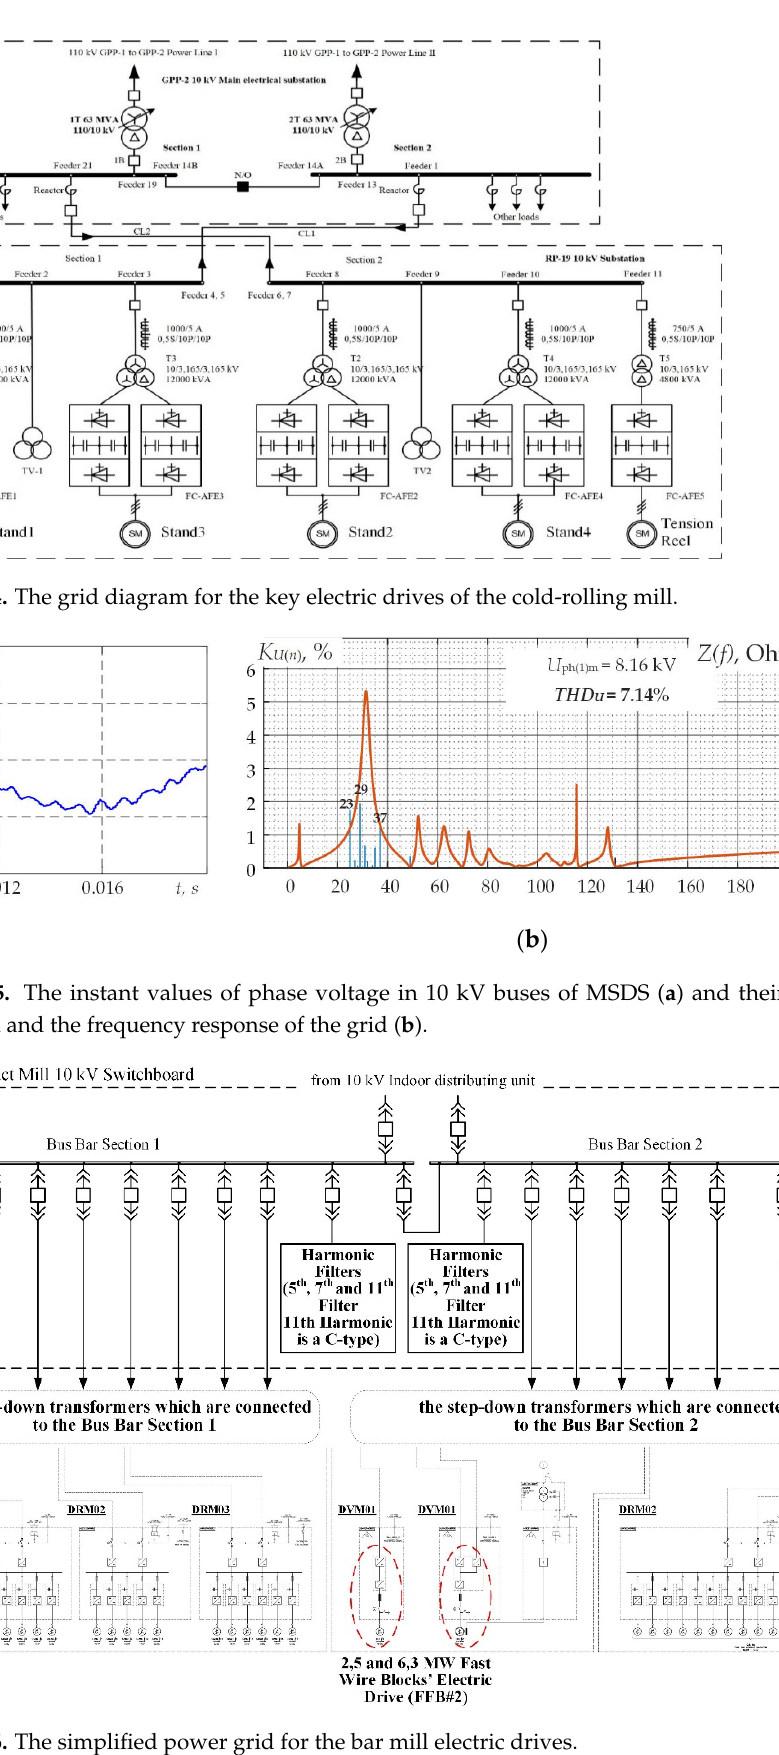
( d ) Figure 17. The instant phase voltage values in the 10 kV buses ( a ) and their harmonic spectrum and grid frequency response ( b ); instant 6.3 MW current values for a Fast Wire Block’s Electric Drive ( c ) and their harmonic spectrum ( d ).